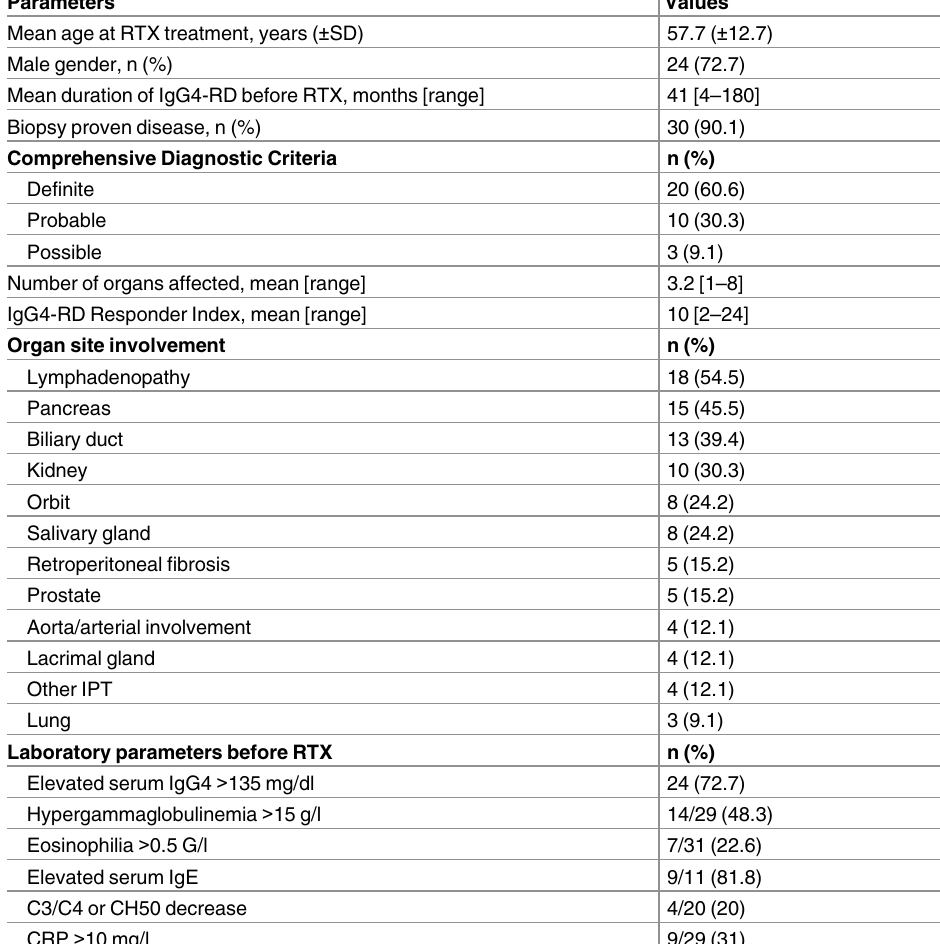
Table 1. Demographic, pathological, clinical and biological baseline characteristics of 33 patients with IgG4-RD treated with RTX. Parameters Values Mean age at RTX treatment, years ( ± SD) 57.7 ( ±